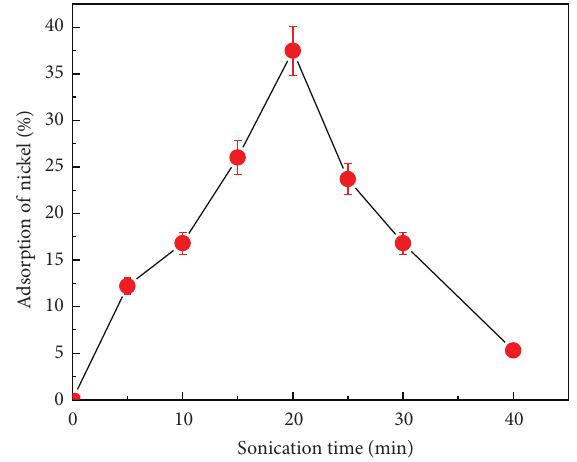
F 1: e effect of sonication times on the removal of Ni